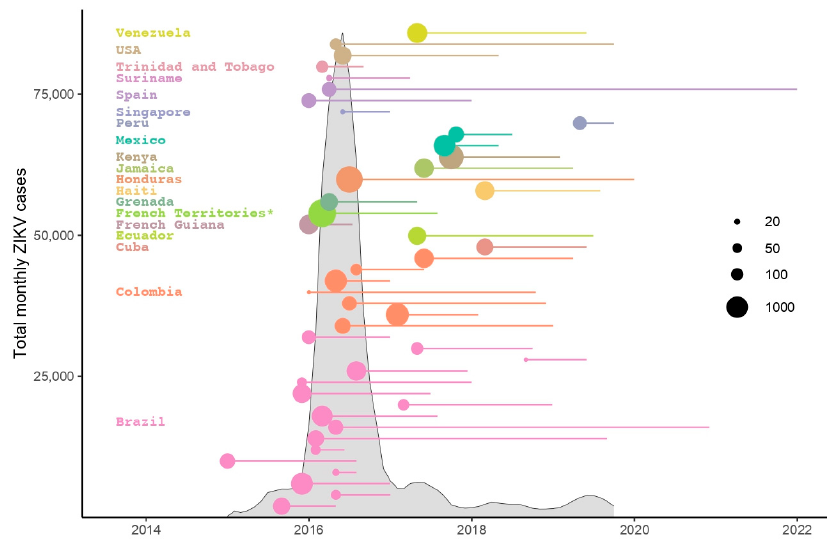
Figure 1. Distribution of monthly Zika virus (ZIKV) cases and Zika virus-related longitudinal studies of pregnant women and their infants and children. Vertical axis shows the total number of monthly reported ZIKV cases for countries / regions listed (6-month moving average of raw data extracted from PAHO PLISA Health Information Platform for the Americas, 2 November 2019). Each of the 42 colored circles represents a participating study with color corresponding to country / region and circle size corresponding to the number of pregnant women enrolled in the study. The horizontal colored lines indicate the time period during which a participating study recruited pregnant women. Ten studies missing information on number of pregnant women enrolled are excluded from the graph. * French Territories include Guadeloupe, Martinique, and French